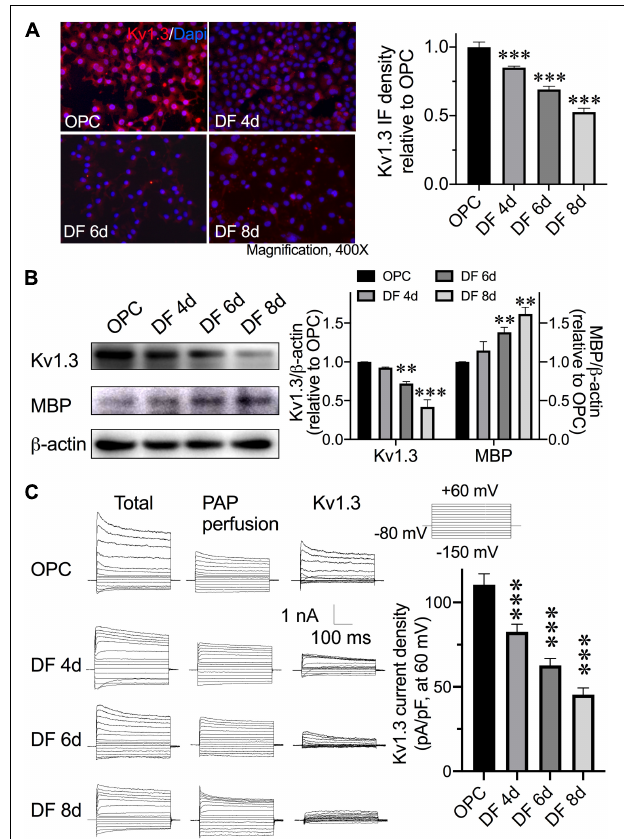
FIGURE 1 | Expression of Kv1.3 in OPCs/Ols during development. OPCs were cultured in OPCDM to differentiate into mature Ols. OPCs were transferred into OPCDM for 4 days (DF 4d), 6 days (DF 6d), and 8 days (DF 8d). (A) Representative images of Kv1.3 immunofluorescence staining (red) in cultures. Intact cell nuclei were visualized with DAPI (blue). The immunofluorescence density of Kv1.3 was summarized in a bar graph at the right. With the maturity of OPCs, Kv1.3 decreased in a development-dependent manner. (B) Western blot analysis of MBP expression in cells collected from different periods of OPCs/Ols. Band densitometry data are shown in the bar graph (right). Data are normalized to β -actin shown in each gel. In contrast to the Kv1.3 alterations, the expression of MBP increased with differentiation. (C) Representative current traces of outward K + currents recorded during depolarizing and hyperpolarizing pulses are shown in cells of OPCs, DF 4d, DF 6d, and DF 8d. The whole-cell outward K + currents recorded before (Total) and 15 min after superfusion of 10 nM PAP (PAP perfusion) to the bath. The Kv1.3 currents were then isolated by subtraction of outward K + currents recorded in the presence of PAP from the total currents (Kv1.3). The summary bar graph illustrating average Kv1.3 current density measured at +60 mV (pA/pF) obtained from OPCs and Ols ( n = 16). With the maturation of Ols, the Kv1.3-conducted potassium currents decreased. All data expressed were obtained from three independent experiments unless otherwise indicated. ∗∗ P < 0.01 vs. control, ∗∗∗ P < 0.001 vs.